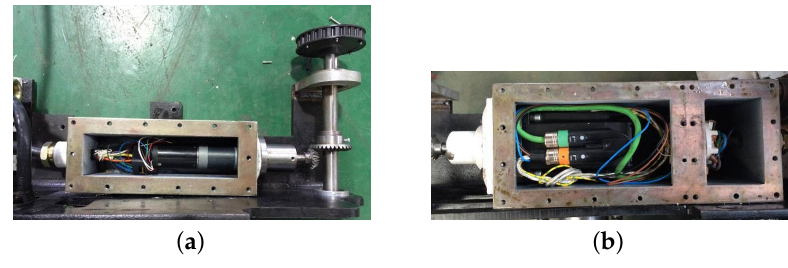
Figure 24. The motors are enveloped in their explosive-proof boxes. ( a ) The swich motor with its explosive-proof box. ( b ) The power motor with its explosive-proof box.